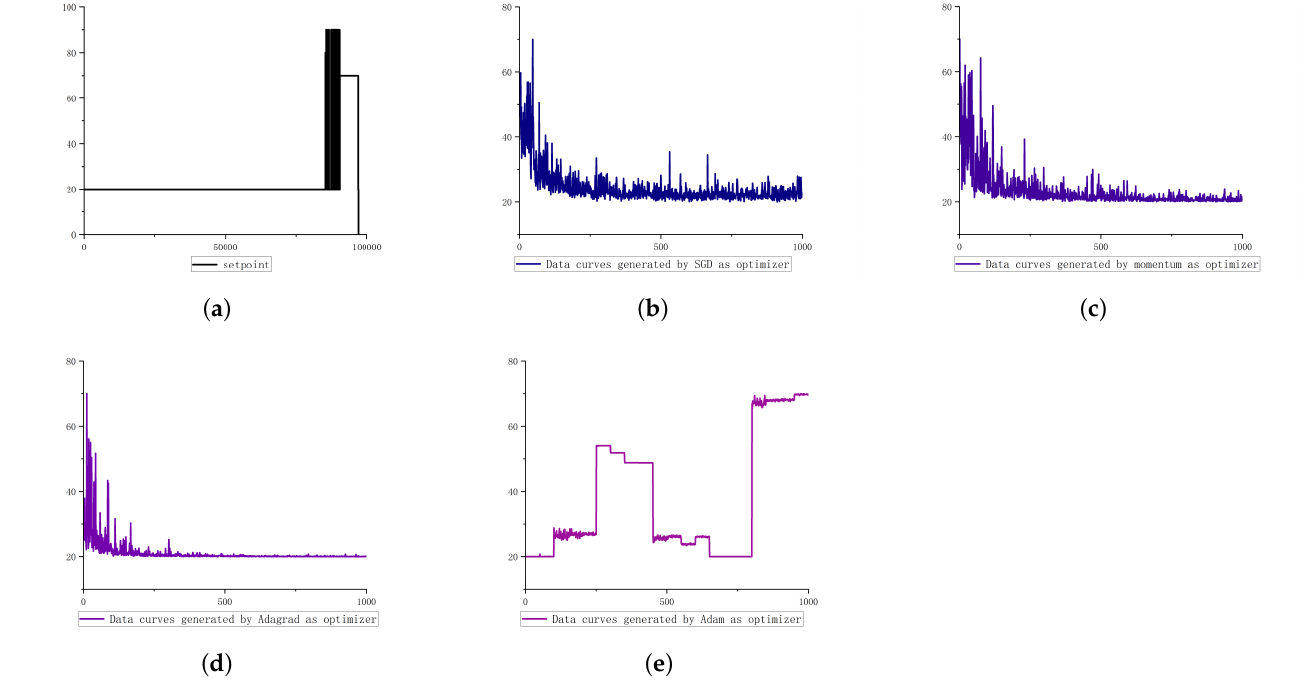
Figure 6. ( a ) Original data of the Setpoint feature of the Mississippi gas dataset; ( b ) SGD is selected as the generation result of the optimizer; ( c ) momentum is selected as the generation result of the optimizer; ( d ) Adagrad is selected as the generation result of the optimizer; ( e ) Adam is selected as the generation result of the